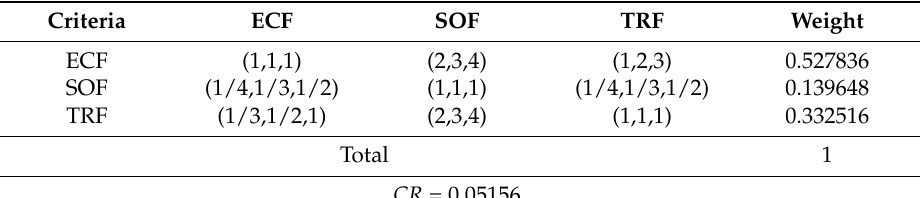
Table A2. Comparison matrix for ENF.